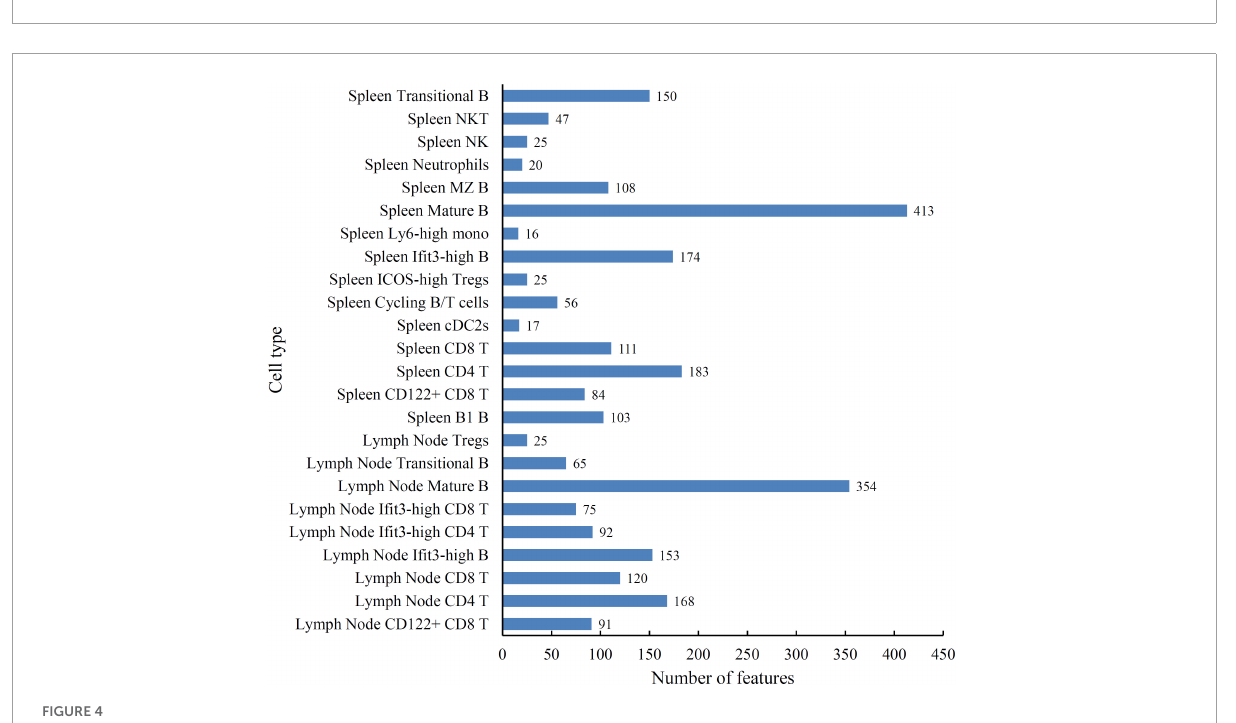
FIGURE3 Violin plot to show the performance of four optimal classifiers on the training and test datasets. (A) Violin plot on the training dataset. (B) Violin plot on the test dataset.